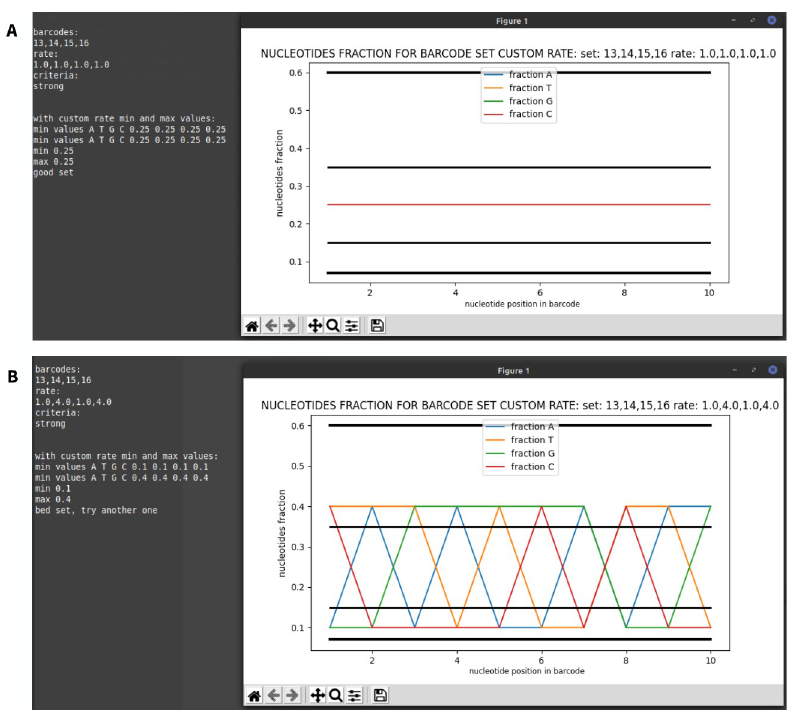
Fig 11. Example of BC-store operation from the command line in case of equal (A) and unequal (B) proportions of barcodes mixed in a set.